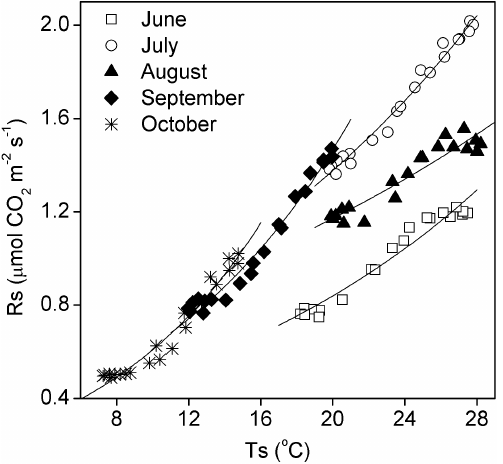
Fig. 3. Lag time between soil respiration (Rs) and soil temperature (Ts) over the diel cycle, in relation to volumetric soil water con- tent (VWC) at 10cm soil depth. The lag times were calculated by a cross-correlation analysis using a three-day moving window with one-day step. The solid line is fitted using linear regression.